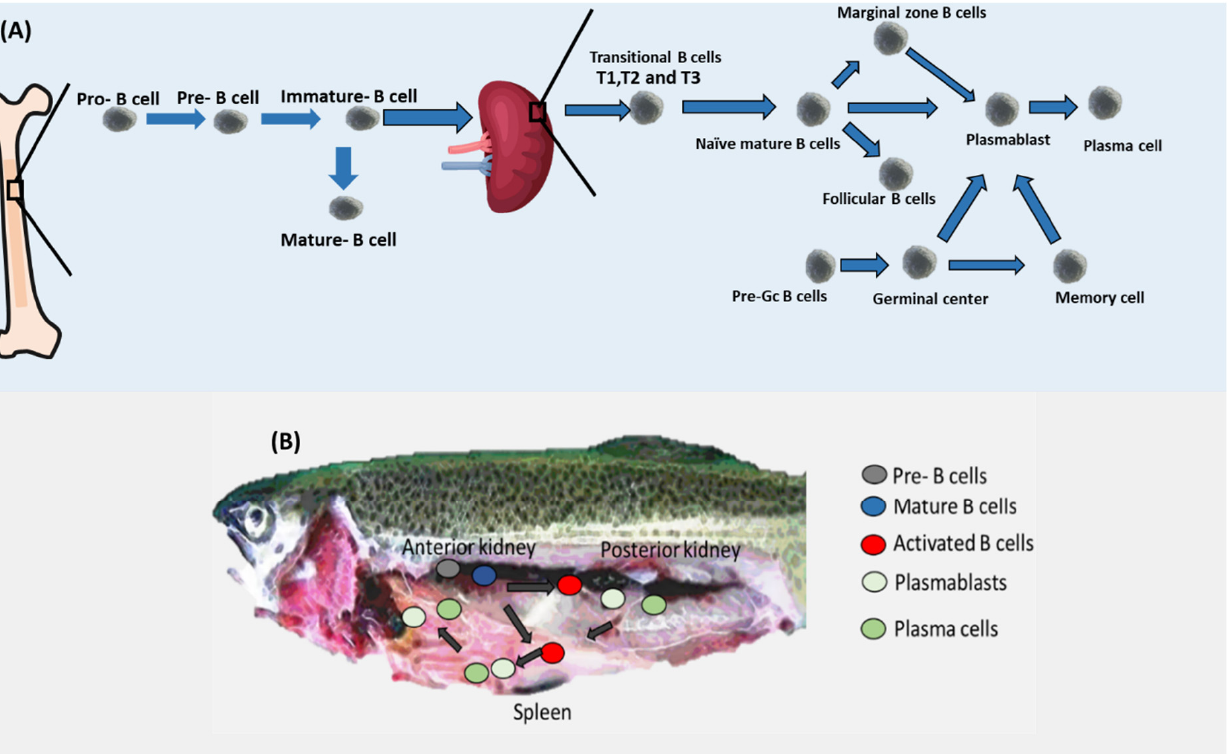
Figure 2. B cell differentiation. ( A ) After appearing in the bone marrow, pre ‐ B cells are transferred to pro ‐ B cells which in turn are converted into immature B cells. Immature B cells leave the bone marrow and migrate to the spleen in the form of transitional B cells that are converted into naïve mature B cells. Naïve mature B cells have three possible fates, namely marginal zone B cells, follicular B cells, and plasmablasts. Pre ‐ Gc cells can also be converted into plasmablasts. Plasmablasts can be transferred into plasma cells. Currently, the position of Bregs within this traditional B cell differentiation map is still obscure. ( B ) B cells in fish. Whereas pre cells were found in the anterior kidney regions in trout, activated B cells seem to migrate to the posterior kidney region and the spleen where they differentiate into plasmablasts and plasma cells.